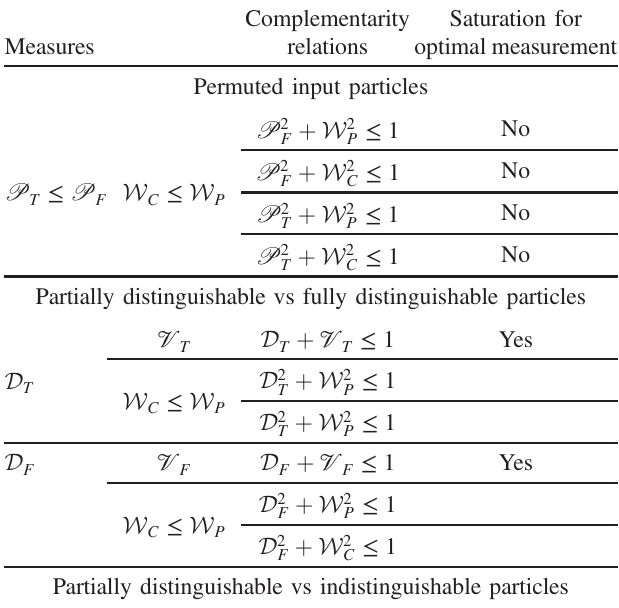
TABLE II. Summary of the relations obtained by comparing the output statistics for initially permuted input particles, between partially distinguishable and fully distinguishable or indistin- guishable particles. Complementarity Saturation Measures relations